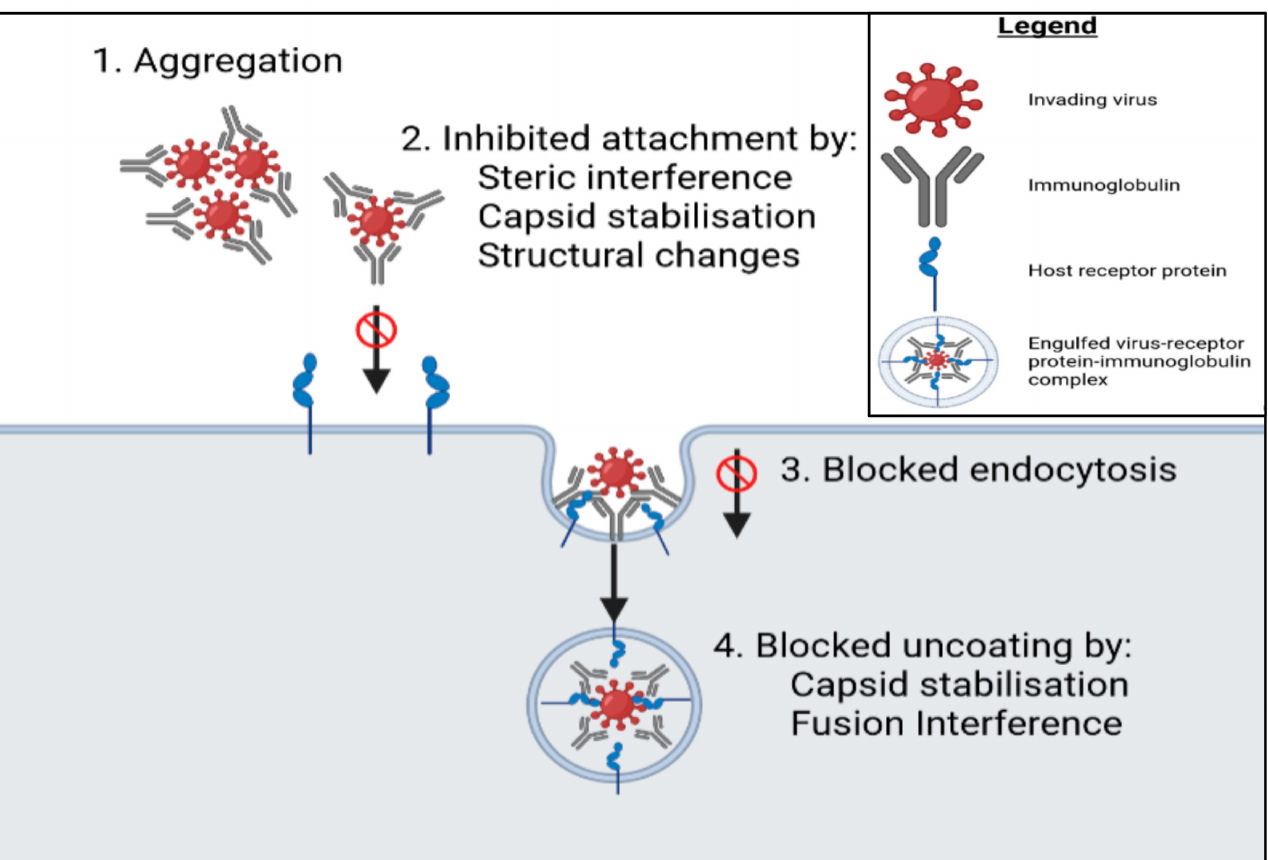
Figure 1. Suggested mechanisms of immunoglobulin-mediated blocking of viral replication. There are 4 possible ways antibody binding can prevent the eventual nucleic acid release of the infecting virus. ( 1 ) By inducing viral aggregation, mucosal antibodies obstruct the movement of virions through mucous, which reduces penetration through epithelial cells, reduces viral access to susceptible mucosal CD4 T cells and dendritic cells, and prevents transcytosis [56]. ( 2 ) Antibody detection of infecting virions can, based on the 3 mentioned techniques, result in the inability for these virions to bind to receptor proteins on susceptible cells, in turn blocking the attachment of the virions to host cells. ( 3 ) Transmembrane receptors are readily endocytosed, which is beneficial to an infecting virion. However, antibodies have the capacity to target these transmembrane receptors, subsequently limiting endocytosis of the receptor-virion complex [57]. ( 4 ) By utilising the 2 techniques mentioned, antibodies may block release of the infecting virus’